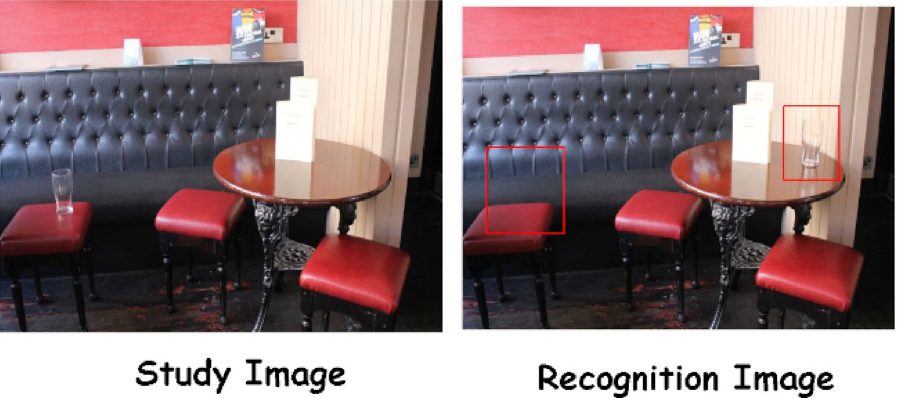
Figure 4. Example of the areas of interest (AOI) created for the Both and Location conditions. The AOI corresponding to the original location where the target was placed during the Study phase (Past Location) is represented by the red square on the left; the AOI corresponding to the new target location during the Recognition Phase (Current Location) is represented by the red square on the